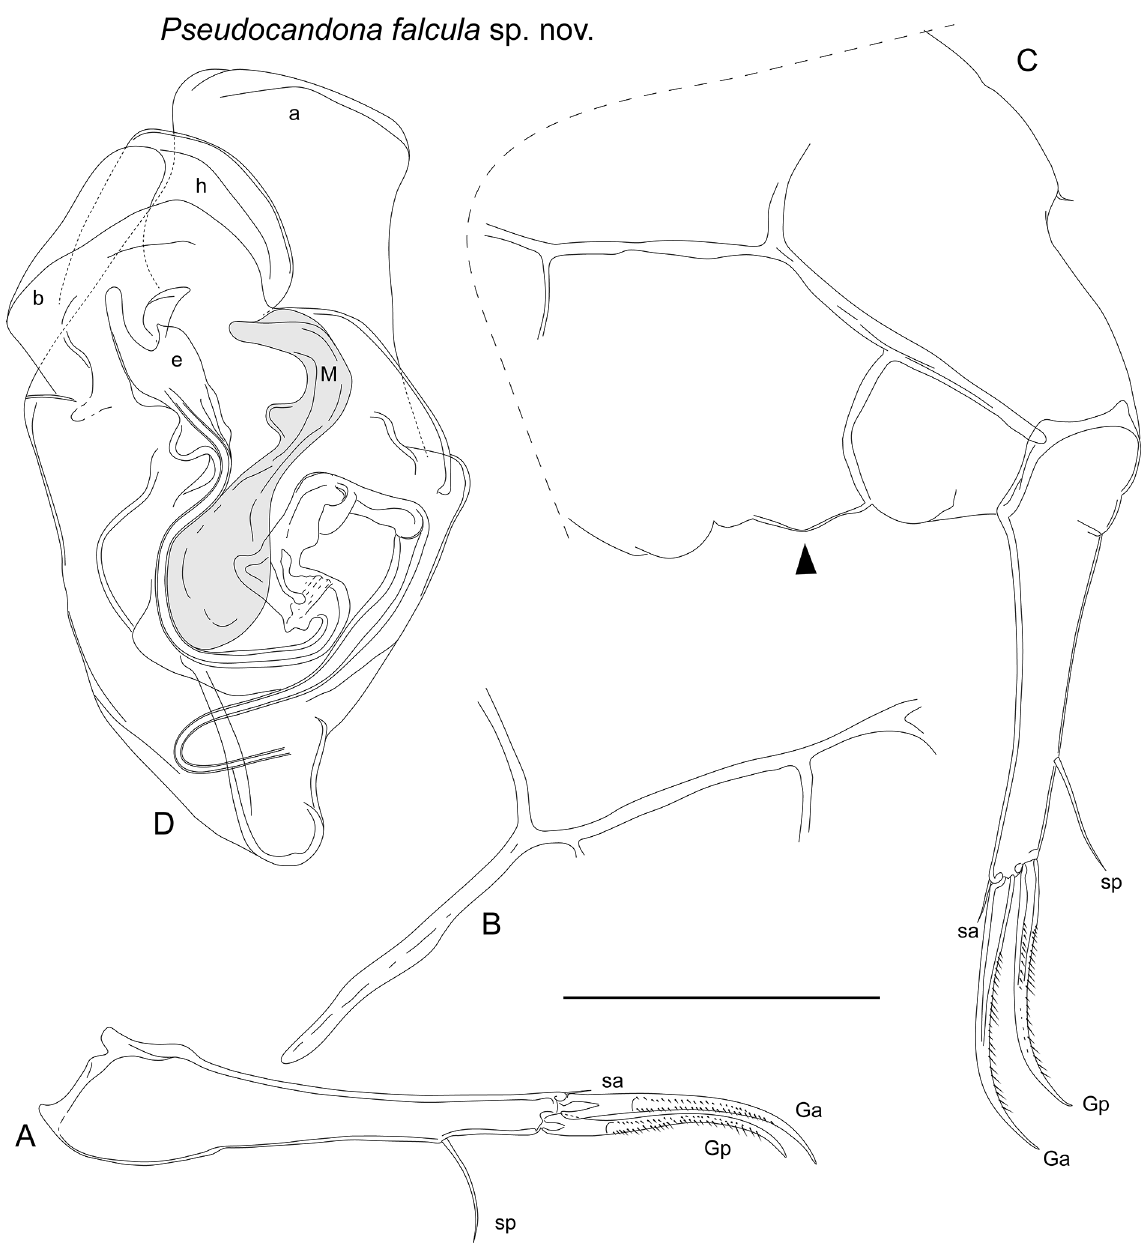
Fig. 13. Pseudocandona falcula sp. nov. A . Male caudal ramus (LBM 1430006275). B . Male caudal ramus attachment (LBM 1430006275). C . Female caudal ramus and genital lobe (LBM 1430006277), black triangle indicates rounded lobe (see text for details). D . Hemipenis (M-process shaded grey) (LBM 1430006275). Scale bar = 151